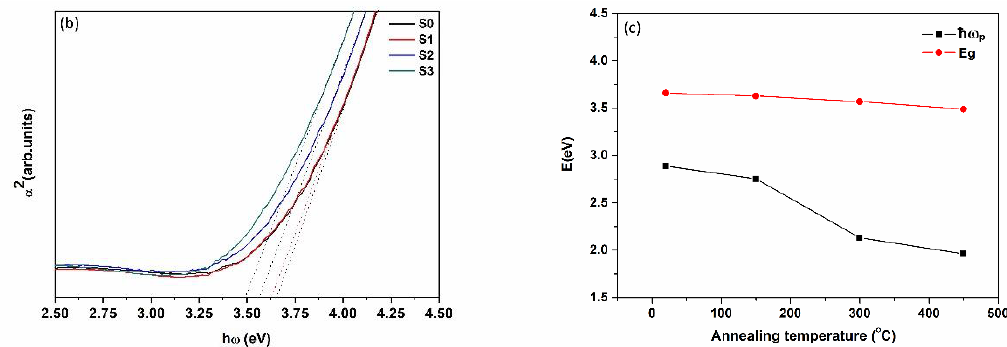
Figure 4. ( a ) The optical absorption of ITO as a function of wavelength; ( b ) α 2 versus h ω curves for the optical band gap determination in the samples; and ( c ) the calculated ¯ h ω p and extrapolated E g as a function of annealing temperature ( ω p was the calculated plasma frequency from Figure 5).